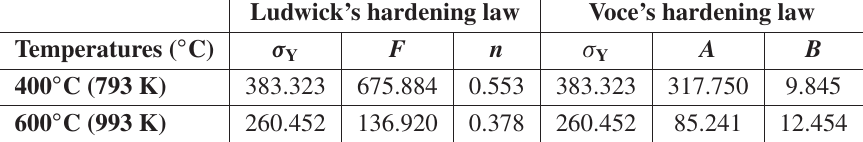
Table 5. Hardening parameters at 400 ı C and 600 ı C.